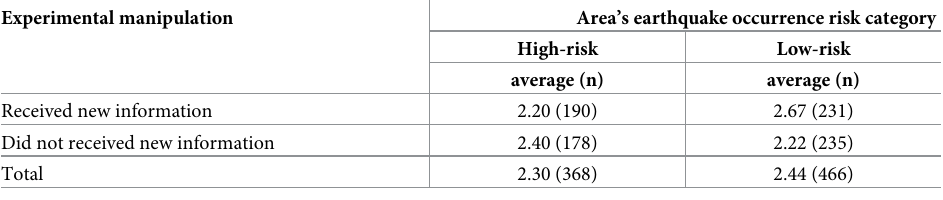
Table 5. Average (on a 4-point scale) willingness to prepare for an earthquake after the experimental manipula- tion, according to residential area(n = 834). Experimental